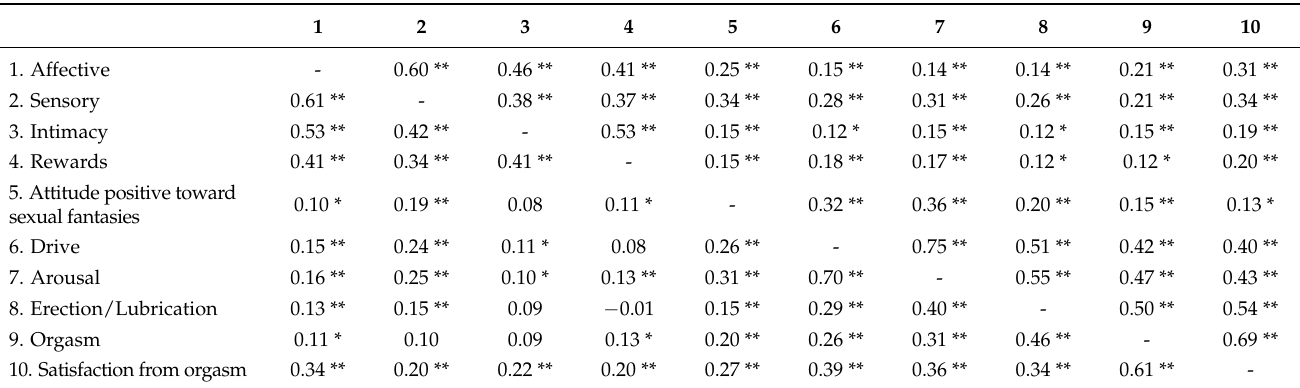
Table 6. Bivariate correlation matrix for subjective orgasm experience, attitude positive toward sexual fantasy and sexual